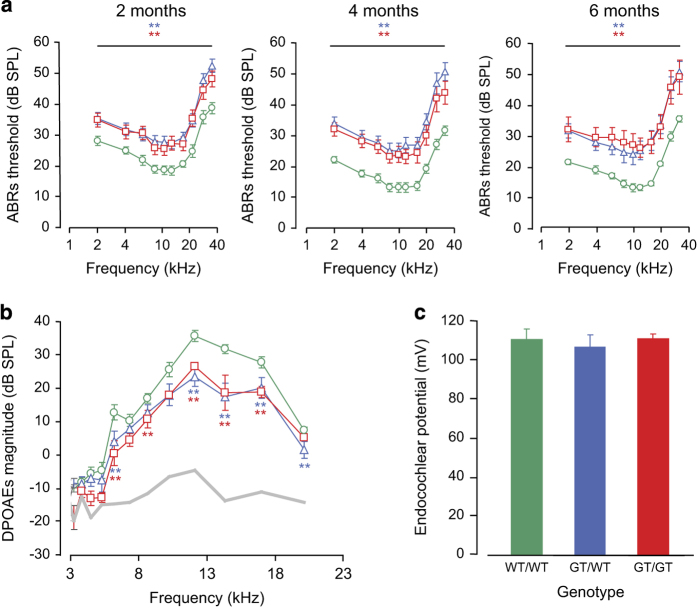
Invalidation of Ywhah induces a mild deafness but does not affect the functioning of the stria vascularis. (a) Audiograms established in 14-3-3etaWT/WT (n=18), 14-3-3etaGT/WT (n=16) and 14-3-3etaGT/GT (n=20) by measuring the brainstem evoked potential thresholds at 10 frequencies ranging from 2 to 32 kHz. Data show a mild (10–20 decibels (dB)) but very significant (P<0.01 for all tested frequencies) threshold elevation in 14-3-3etaGT/WT (blue triangles) and 14-3-3etaGT/GT (red squares) mice as compared with 14-3-3etaWT/WT (green circles) at 2, 4 and 6 months. (b) This panel displays cubic DPOAE (2f
1−f
2) audiograms represented as a function of f
2. The magnitude of the distortion product is slightly reduced in 14-3-3etaGT/WT (blue triangles; n=14) and 14-3-3etaGT/GT (red squares; n= 6) as compared with 14-3-3etaWT/WT mice (green circles; n=14). This reduction is significant between 6 and 20 kHz. The gray line represents the noise floor. (c) Endocochlear potentials were recorded in 14-3-3etaWT/WT (green bar; n=5), 14-3-3etaGT/WT (blue bar; n=5) and 14-3-3etaGT/GT mice (red bar; n=5). No significant difference was seen between the three genotypes. Data are mean±S.E.M.